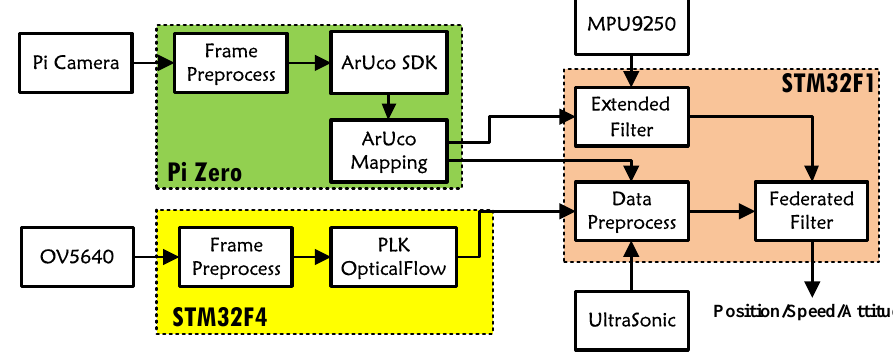
Figure 5. On-board Module Structure Diagram.